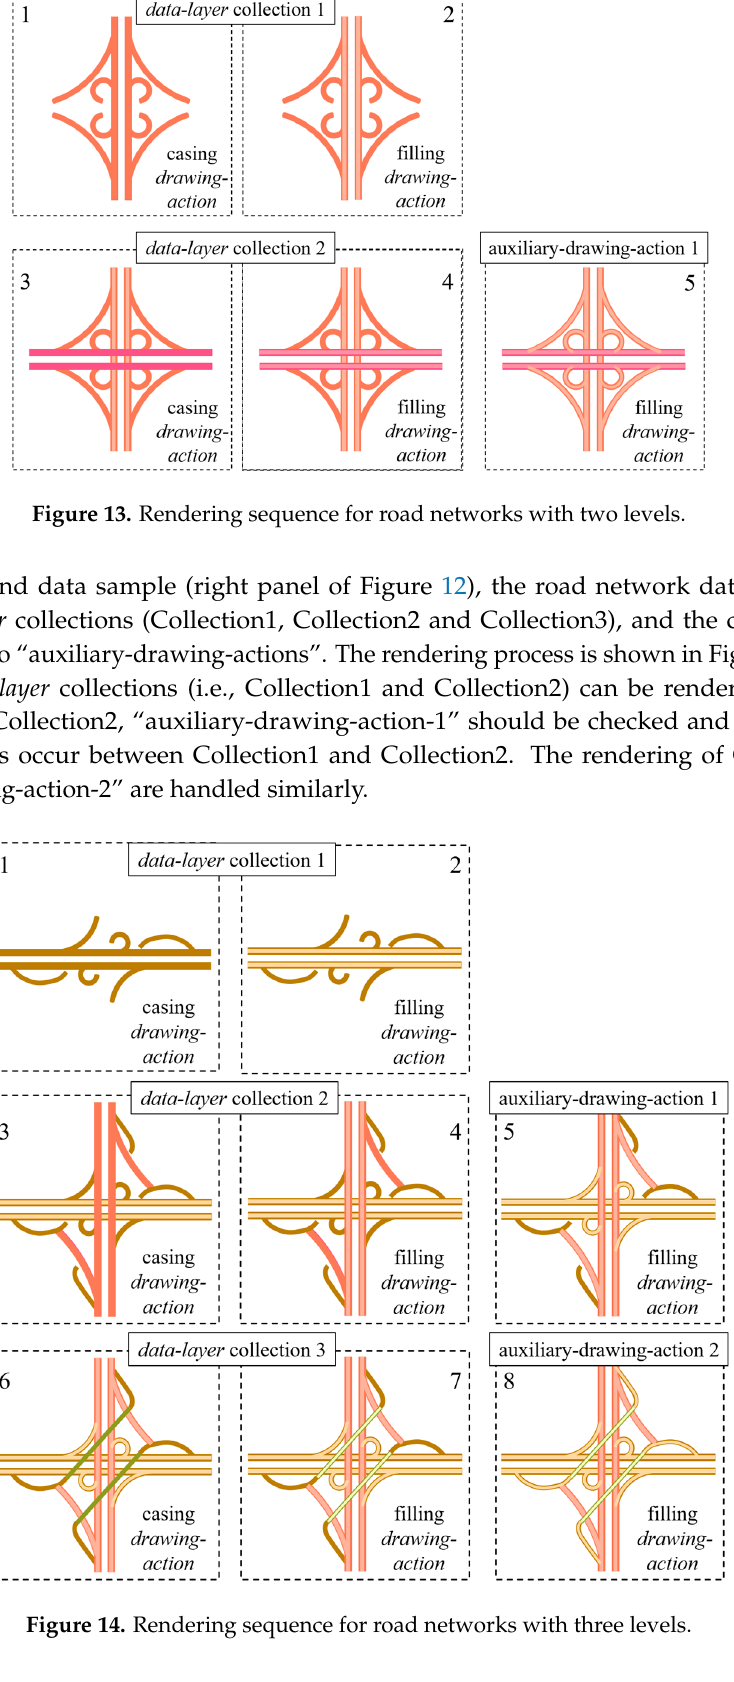
Figure 12. Two road networks with different elevations.